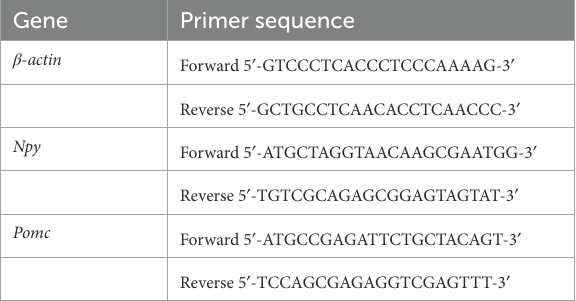
TABLE 1 Primers used for